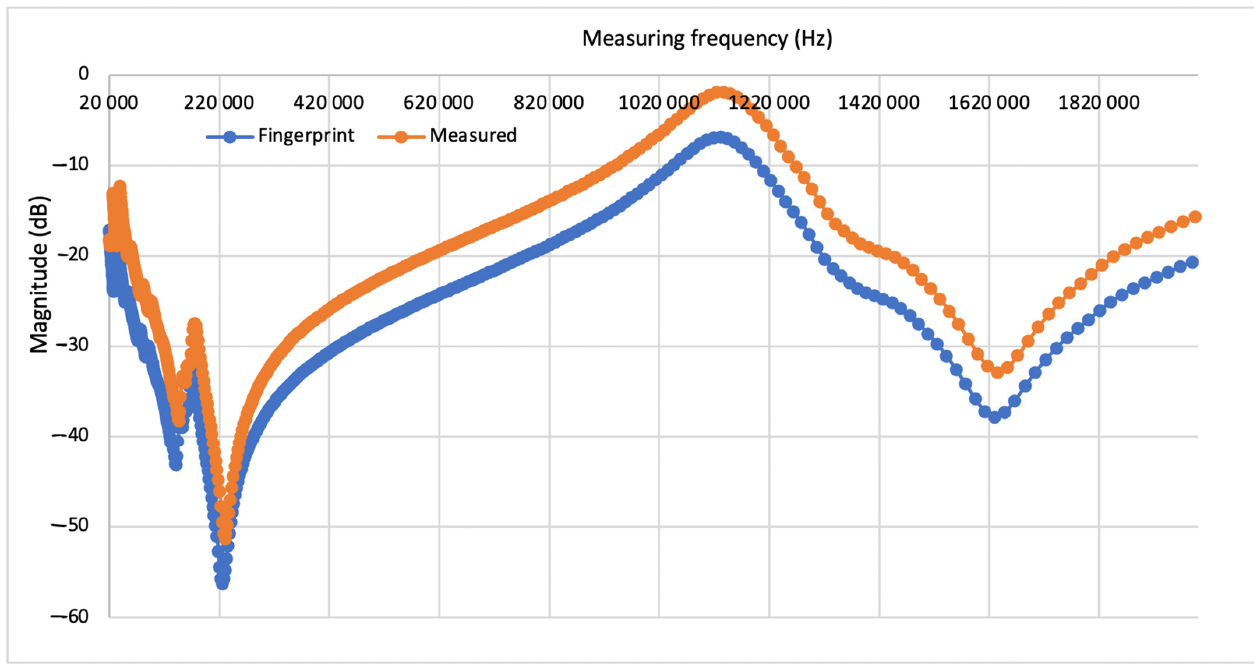
Figure 5. Case study 2: FRA measurement. Table 8. Case study 2 ANOVA results.